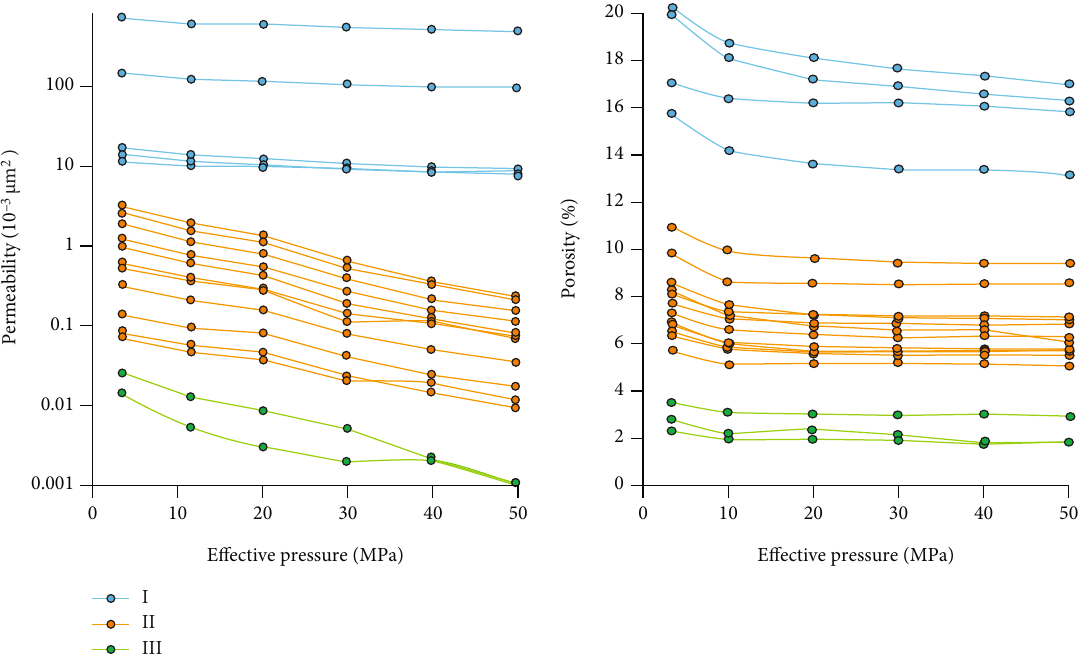
Figure 8: Low-temperature nitrogen adsorption and desorption isotherm for tight sandstone in the study area.